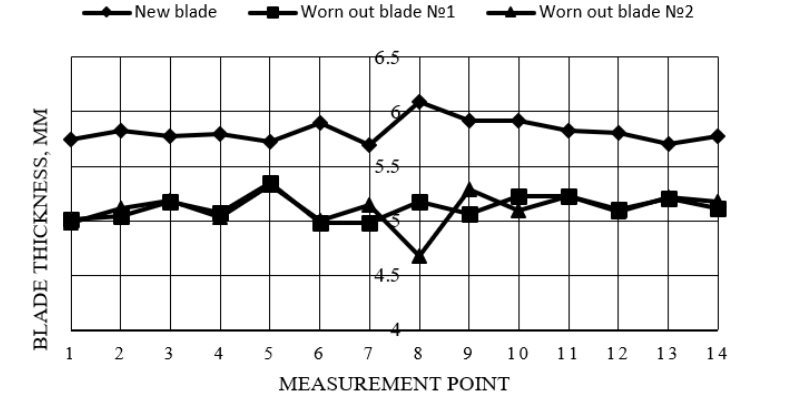
Fig. 4. Change in metal thickness of cultivator blades of MARATHON SERIES made in the USA while operating